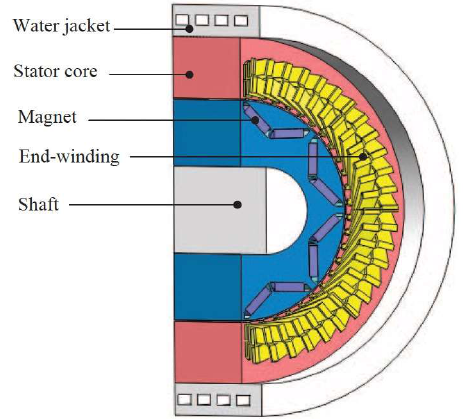
Figure 2. An electric motor cooled by water jacket [24].